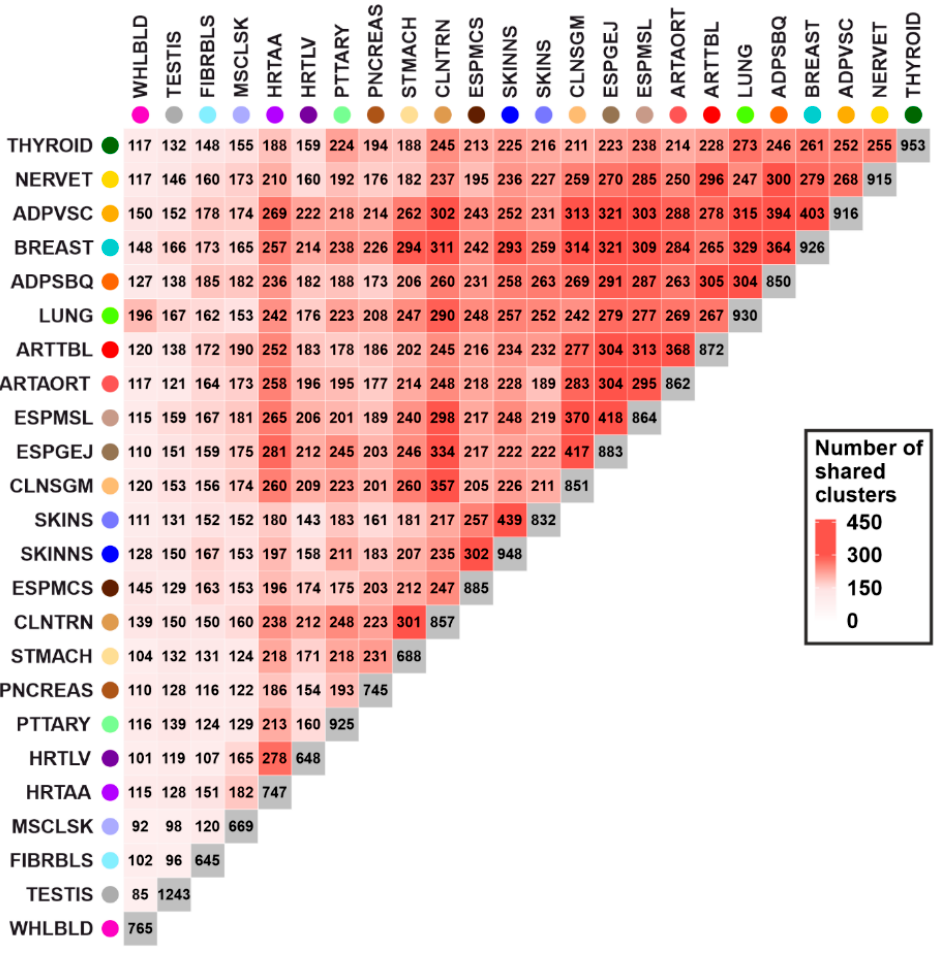
Figure 4. Comparison of gene expression regulation clusters between tissues. The heatmap displays the number of identical clusters between tissue pairs. Clusters in one tissue, which included additional genes in the other tissue, were also counted in this comparison. The color scale represents the number of shared clusters between tissues. Hierarchical clustering of tissues was performed based on commonly regulated gene expression clusters. Only tissues with a sample size above 200 were included in this analysis. A detailed list of tissues analyzed, and their respective abbreviations, is given in Table